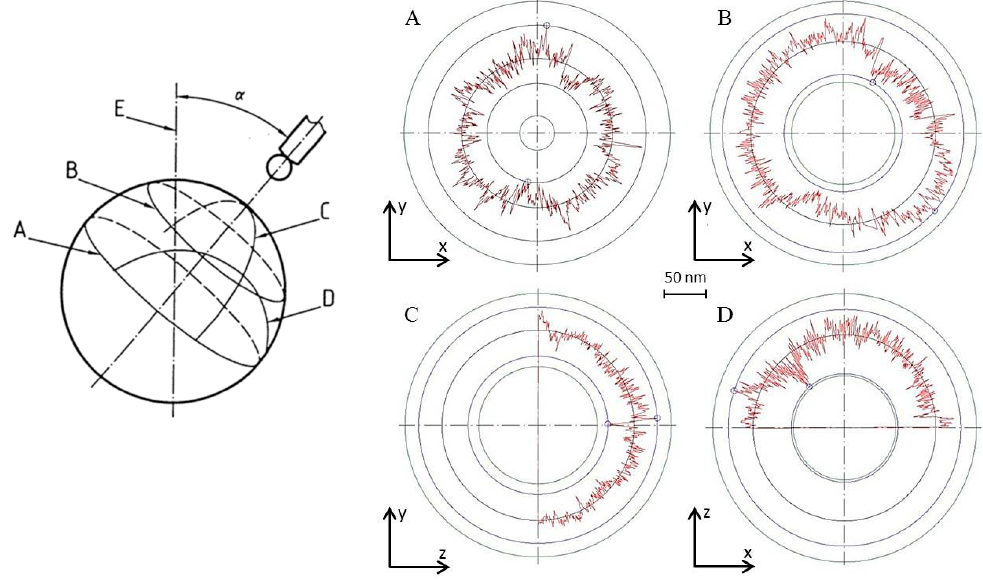
Figure 5. Determination of the single point probing error according to ISO 10360-4 on a 1 mm ruby sphere: ( left ) Arrangement of scanning profile planes A, B, C and D; ( right ) Measured profiles A to D resulting in a scanning probing error T ij = 87 nm.